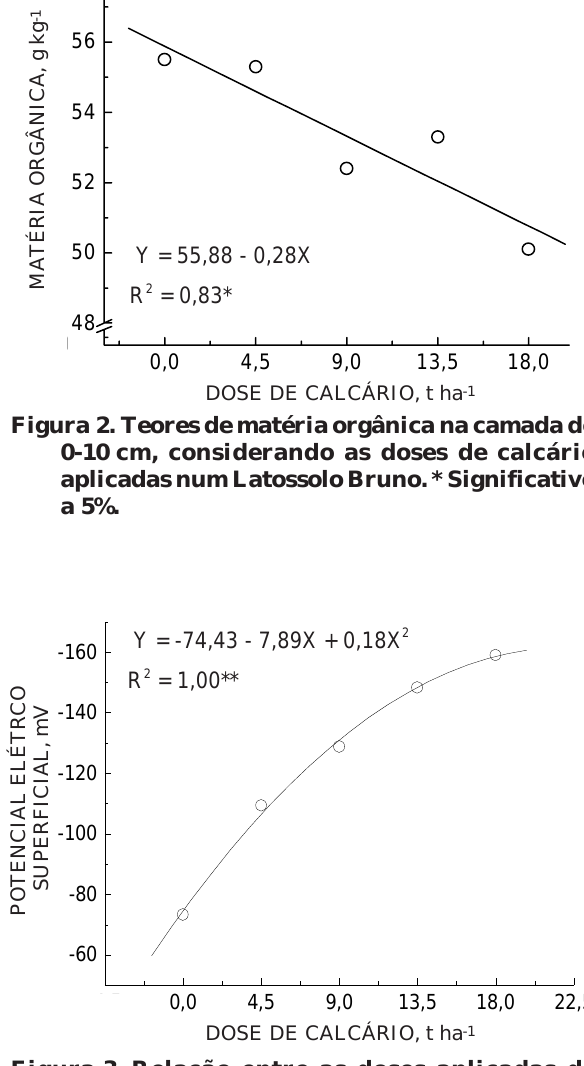
Figura 3. Relação entre as doses aplicadas de calcário e o potencial elétrico superficial.